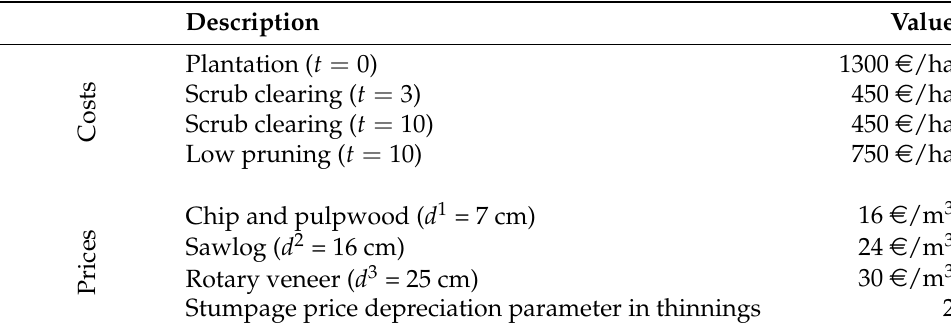
Table 1. Economic parameters used for the